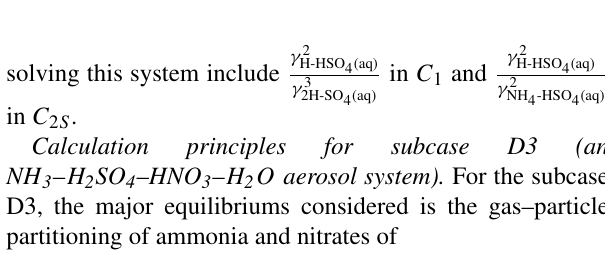
Figure D1. Drivers of the difference in c ni estimated by the ISORROPIA and E-AIM models for the NH 3 –H 2 SO 4 –H 2 O system. The ζ g / p of NH 3 indicates the molar ratios of NH 3 (g) to particle-phase NH + 4